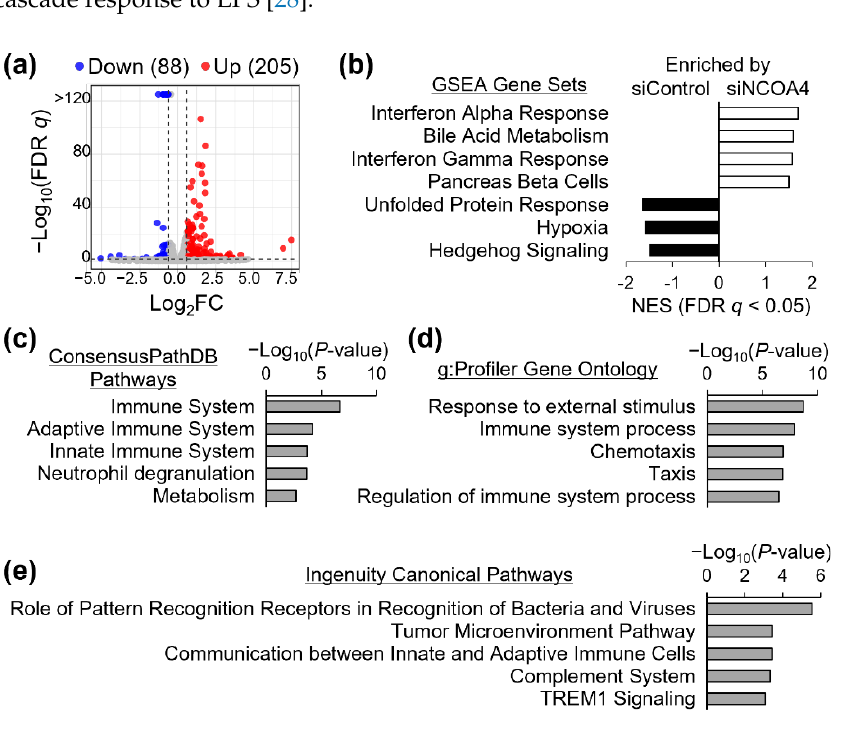
Figure 6. Transcriptome analyses of NCOA4 deficiency in J774 cells reveal gene responses function- ally associated with immune system. Transcriptome of control and NCOA4 siRNA-treated cells were profiled via RNA-seq. ( a ) Total of 293 transcript responses were identified using |FC| > 1.5 and FDR-adjusted q < 0.05 as thresholds for differential expression and significance, respectively ( n = 3 biological replicates). Among these, 88 were identified upregulated, while 205 genes were downregulated by NCOA4 deficiency. ( b ) Gene set enrichment analysis (GSEA) revealed enrichment of interferon response and hypoxia gene sets by genes with higher expressions in NCOA4 and control siRNA-treated cells, respectively. ( c ) ConsensusPathDB, ( d ) g:Profiler, and ( e ) Ingenuity Pathway Analysis tools commonly present over-representation of genes functionally annotated to immune system networks and pathways by NCOA4-responsive genes.